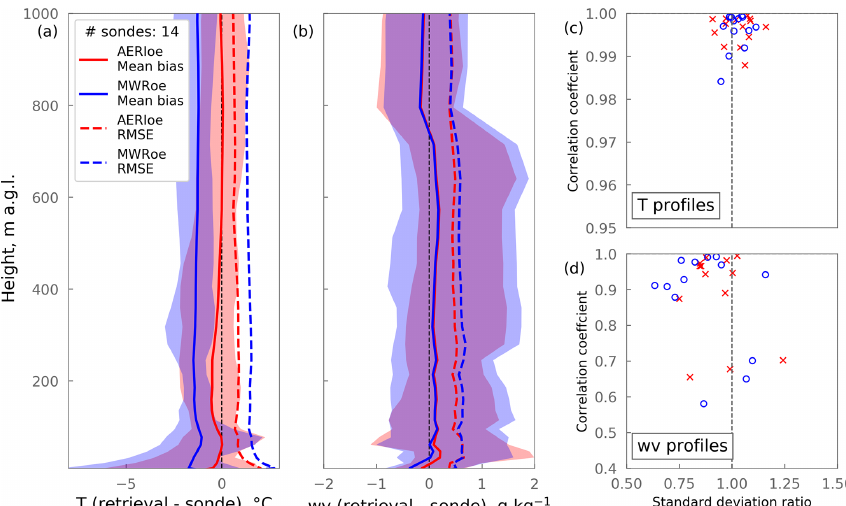
Figure 4. Comparison between retrieved thermodynamic profiles and the 14 coincident radiosonde profiles in the lowest 1kma.g.l. (a) The temperature and (b) and water vapour bias (retrieval – radiosonde) for AERIoe retrievals (red) and MWRoe retrievals (blue); the solid line shows the mean bias and the shaded represents the range. Dashed lines show the root-mean-squared error (RMSE). (c) The temperature and (d) water-vapour-modified Taylor plots showing the relationship between the correlation coefficient and standard deviation ratio for each retrieval/radiosonde pair ([1,1] represents a perfect score) for the AERIoe retrievals (red) and the MWRoe retrievals